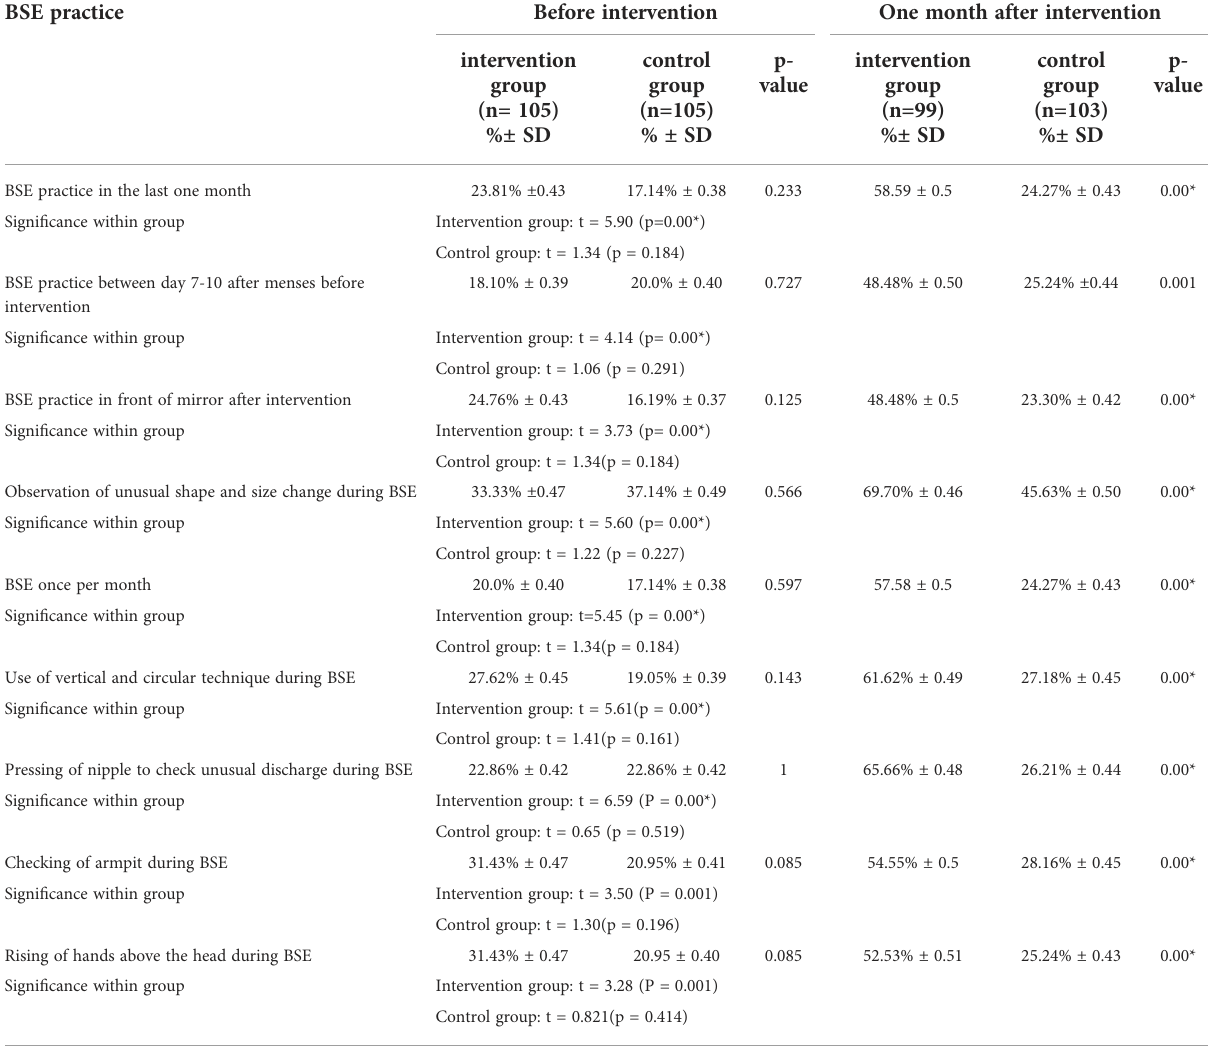
TABLE 4 Mean differences between the intervention and control groups regarding BSE practice score among female students of Debre Markos University, Amhara, Ethiopia before and 1 month after educational intervention about BC based on HBM (n = 210) 2021. BSE